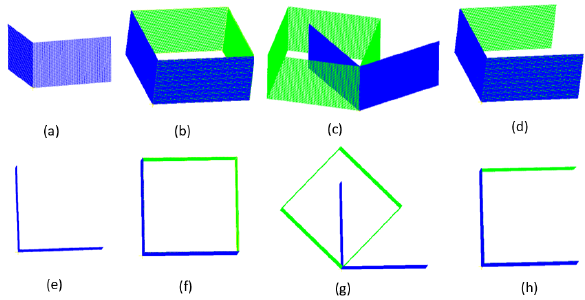
Figure 4: Point cloud C 2 . The leftmost column shows C 2 alone. The remaining 3 columns show the overlapping of C 2 with M 1 , M 2 and M 3 , from left to right.